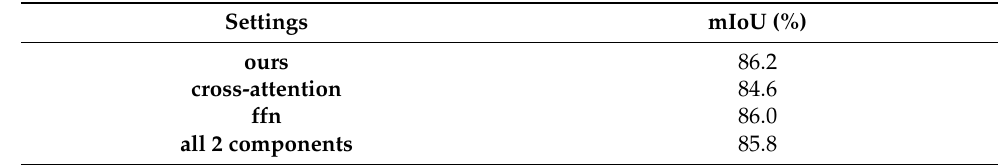
Table 5. Effect of different resolution features. Table 6. Effect of the component in the transformer